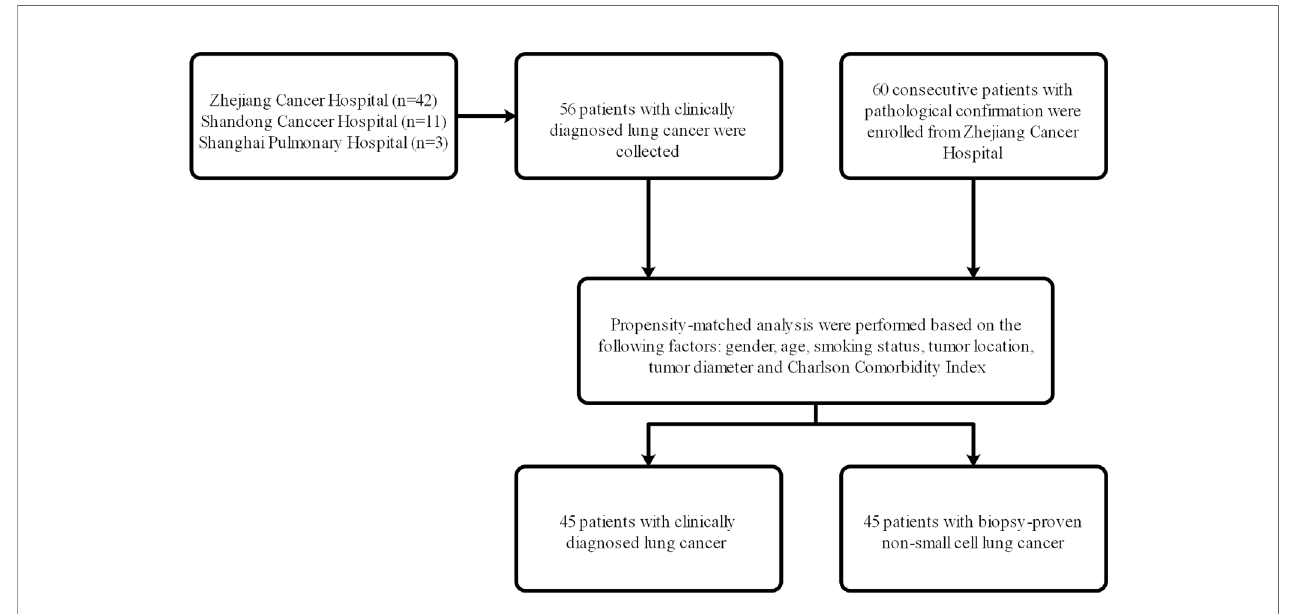
FIGURE 1 | The fl ow chart of patient